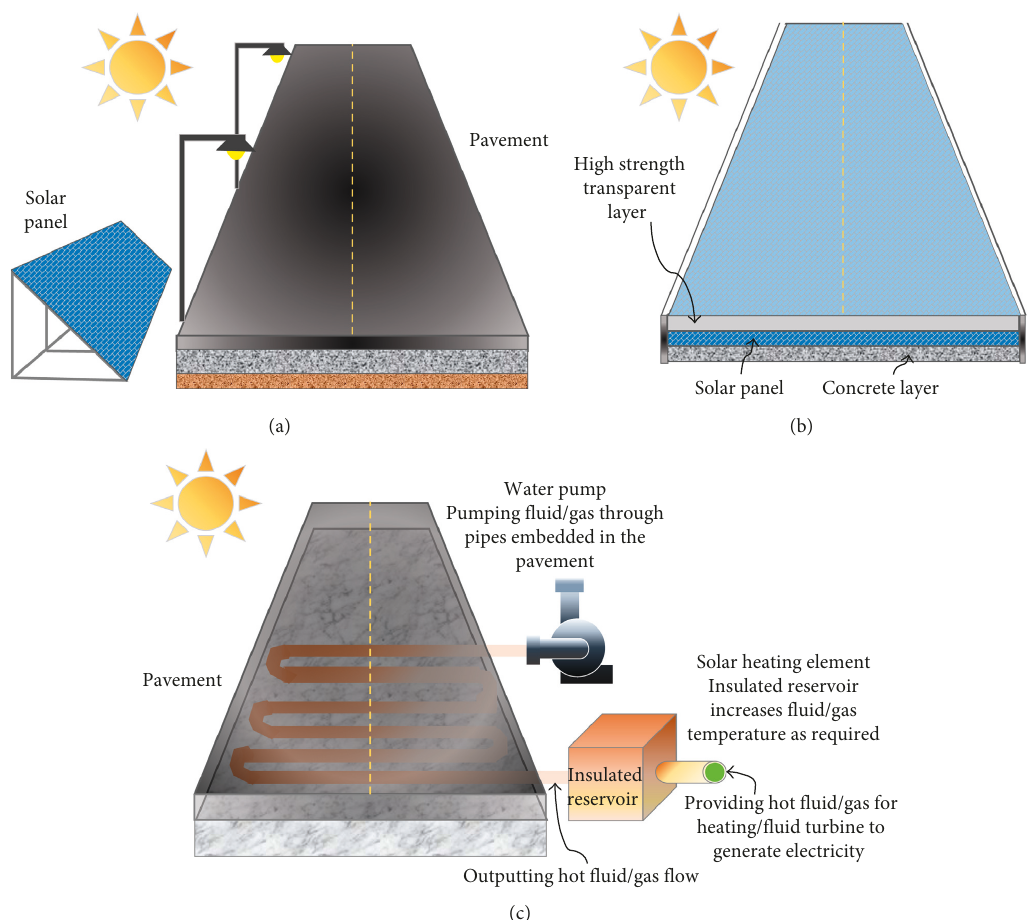
Figure 6: Solar energy harvesting technologies for pavements: (a) solar panel (based on [56]), (b) photovoltaic pavement (based on [57, 58]), and (c) heat extraction with the piping system (fluid/gas) in pavements (based on [10,